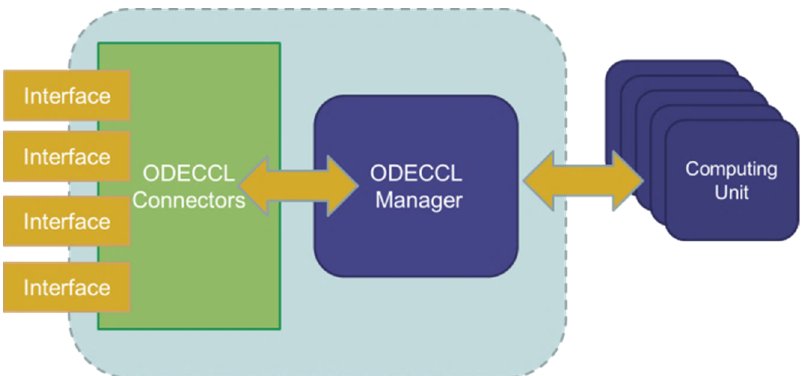
Figure 3. Solver system architecture. The interfaces provide the possibility of define specific tasks for the ODE solver. The ODE Computing platform OpenCL (we call it ODECCL) is composed of three parts. The manager will be assigning/allocating resources depending on their availability. Tasks are defined based on the different interfaces of ODECCL.